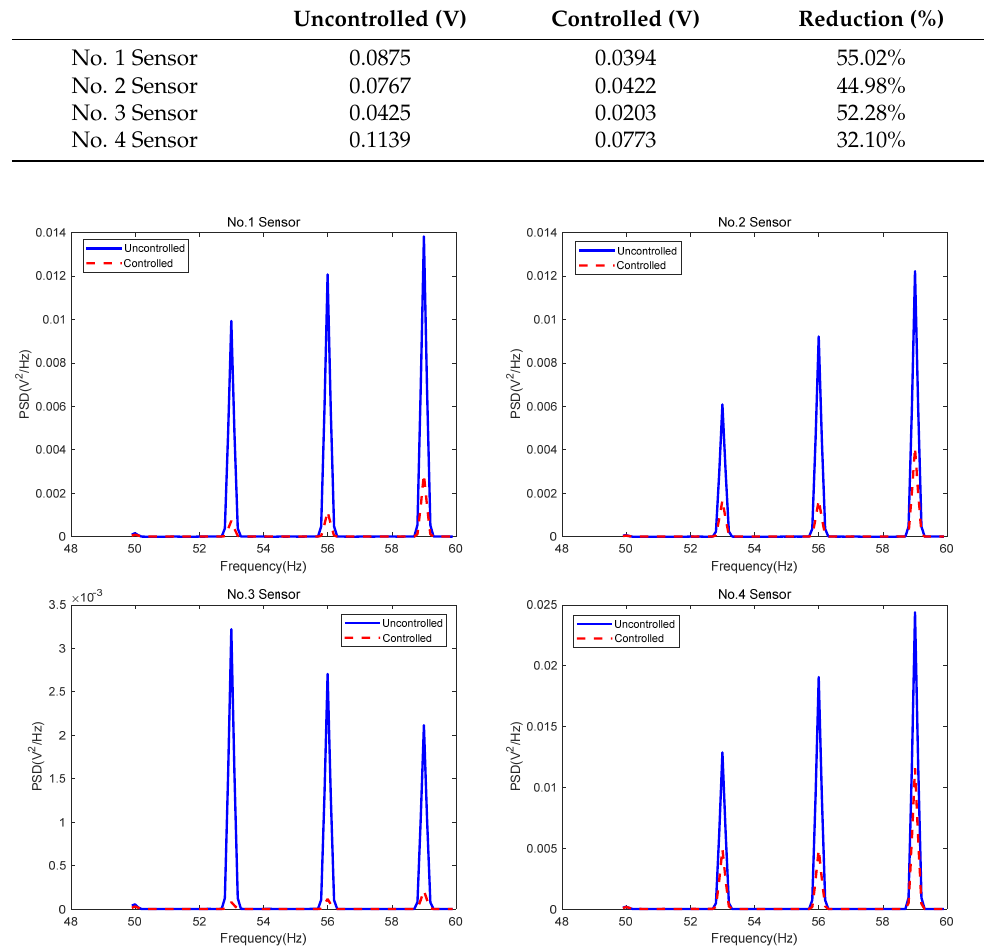
Table 7. RMS values of PSD curves of sensor signals: Experiment #3.